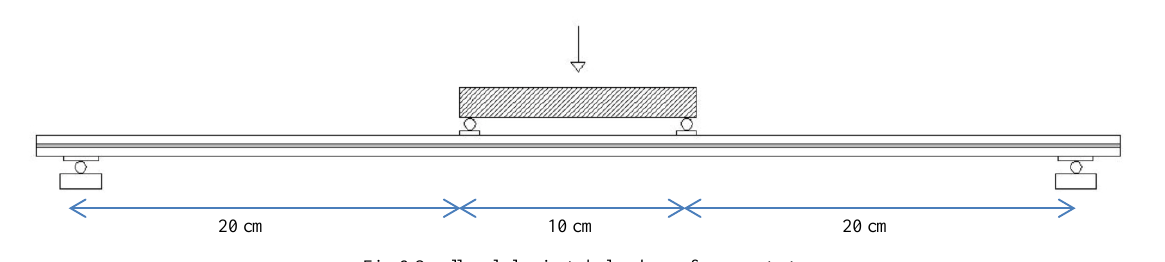
Fig. 3 Small scale laminated glass beam for creep